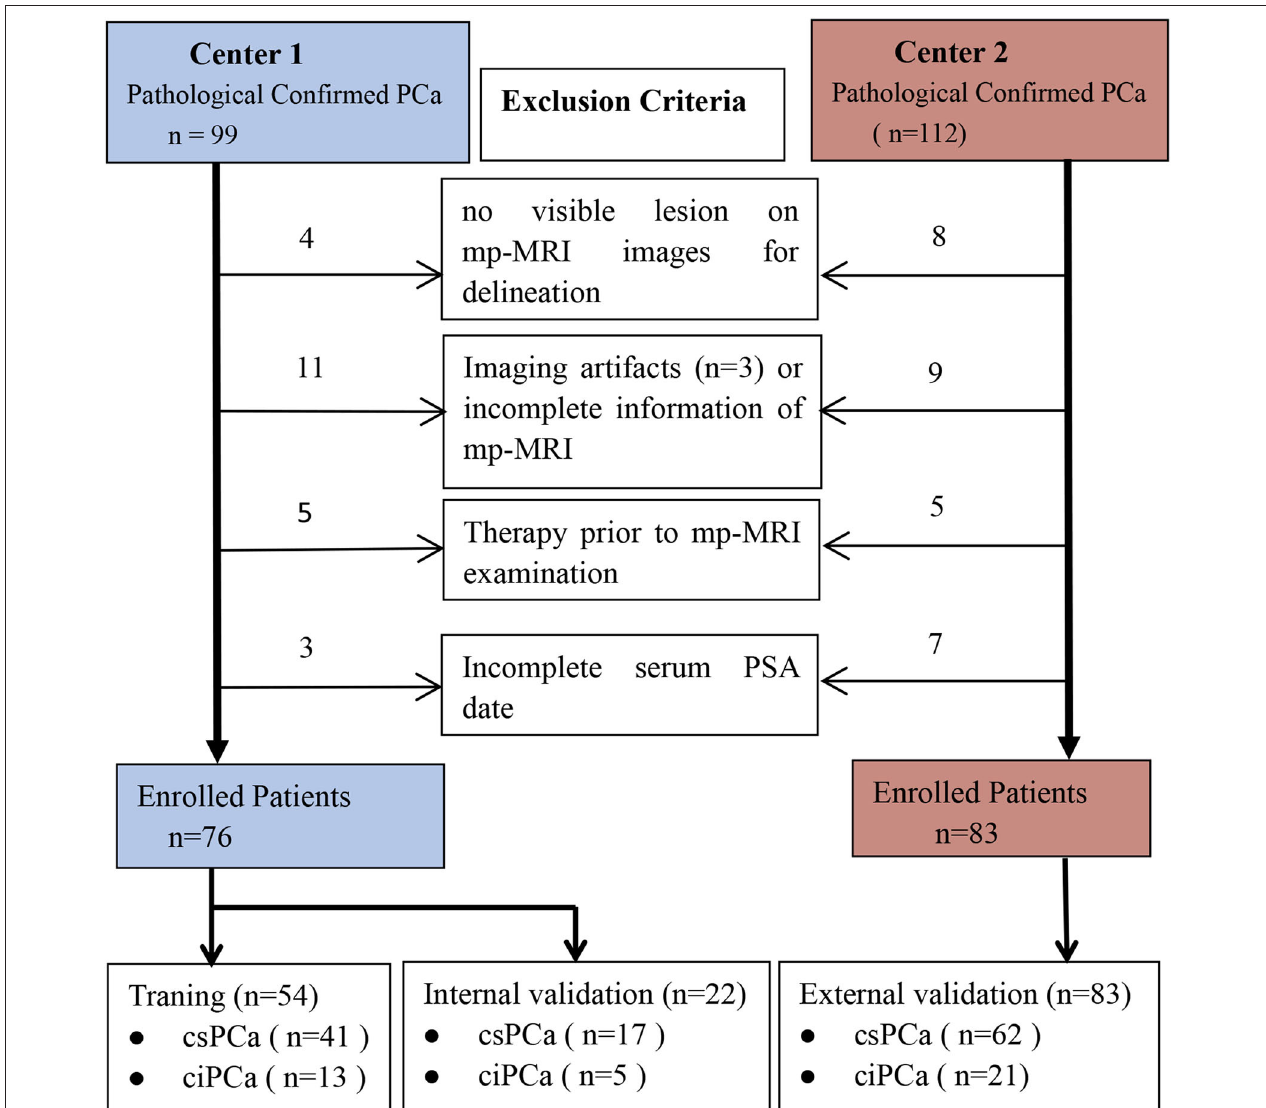
FIGURE 1 | Diagram for inclusion of patients into the study. csPCa, clinically significant prostate cancer; ciPCa, clinically insignificant prostate cancer; mp-MRI, multi-parametric MRI; PSA, prostate-specific antigen.